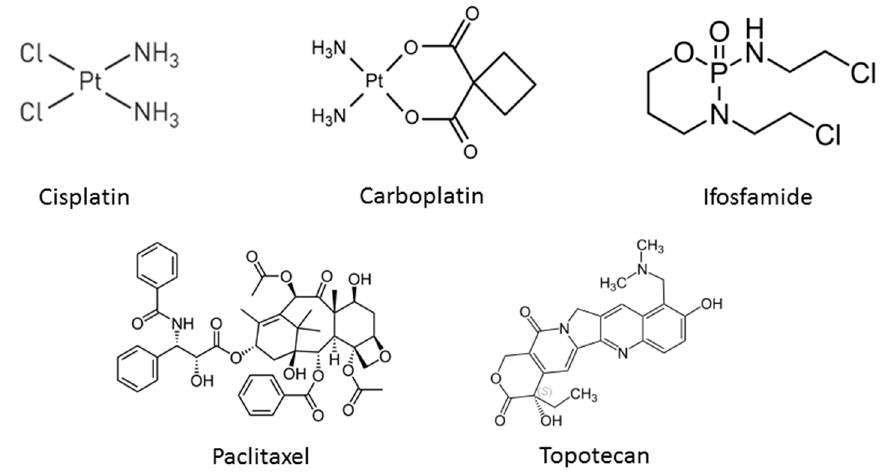
Figure 1. The chemical structures of commonly used chemotherapeutic drugs in cervical cancer.